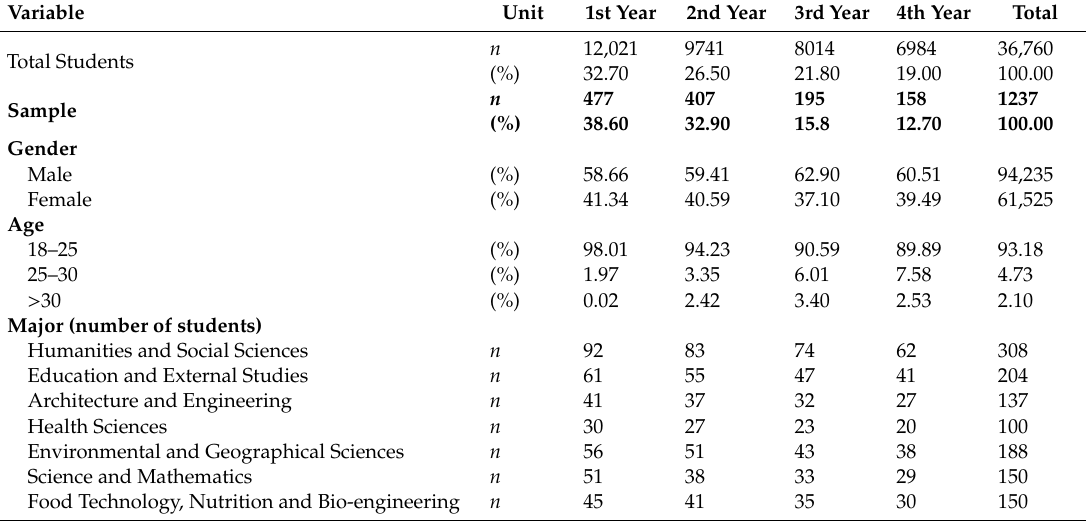
Table 2. East African (EA) universities students’ data variables by class year, 2019.